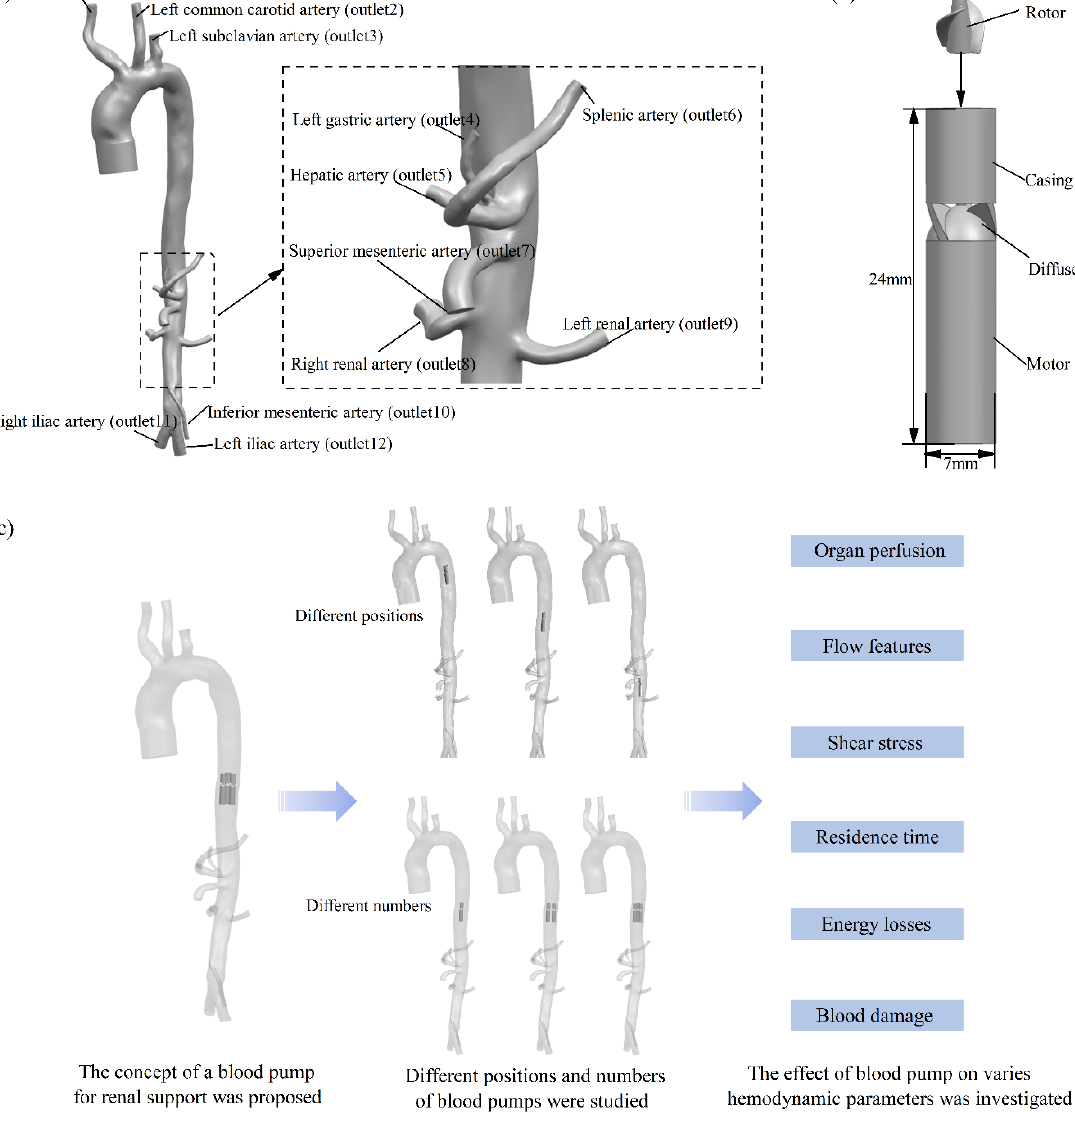
Figure 1. Studied models: ( a ) human arterial model; ( b ) modified Impella 5.0 blood pump for intra-arterial fluid behavior; ( c ) the three different positions and quantities of arterial intravascular pumps studied.